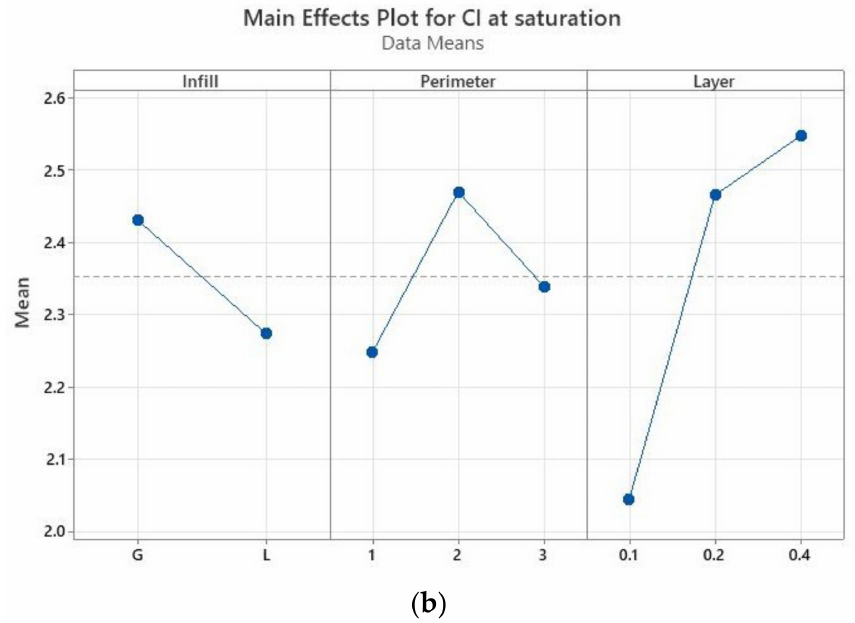
Figure 5. Main effect plots for the absorption rate: ( a ) after 30 min of immersion, ( b ) at saturation.